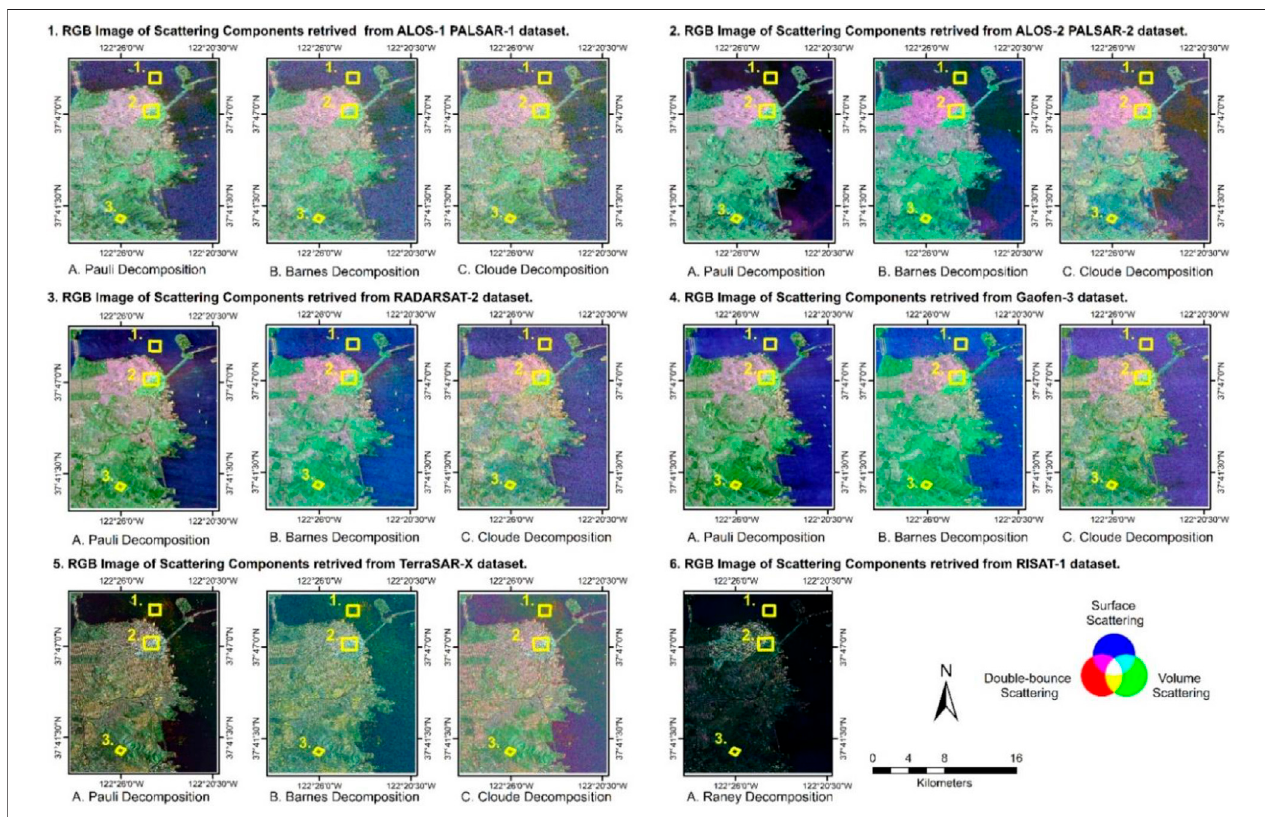
FIGURE 3 | Scattering components retrieved from multi-temporal and multifrequency SAR sensor ALOS-1 PALSAR-1, ALOS-2 PALSAR-2, RADARSAT-2, RISAT-1, Gaofen-3, and TerraSAR-X datasets. Color composite RGB image of (A) Pauli, (B) Barnes, (C) Cloude scattering components: red-double-bounce scattering, green-volume scattering, and blue-surface scattering; Location of (1) water, (2) urban, and (3) vegetation regions for analysis of scattering response.